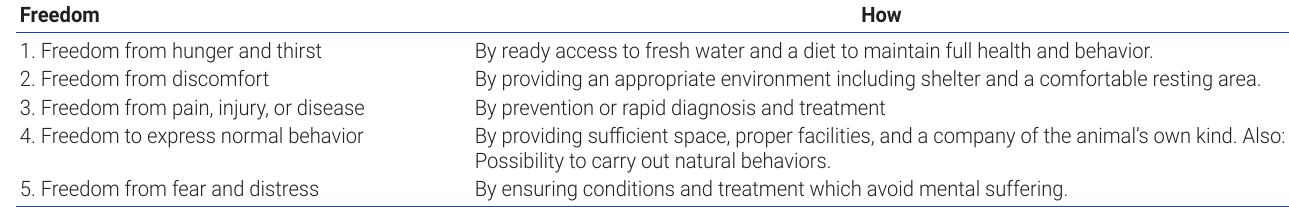
Table 1. The five freedoms as the fundamental experience goals for